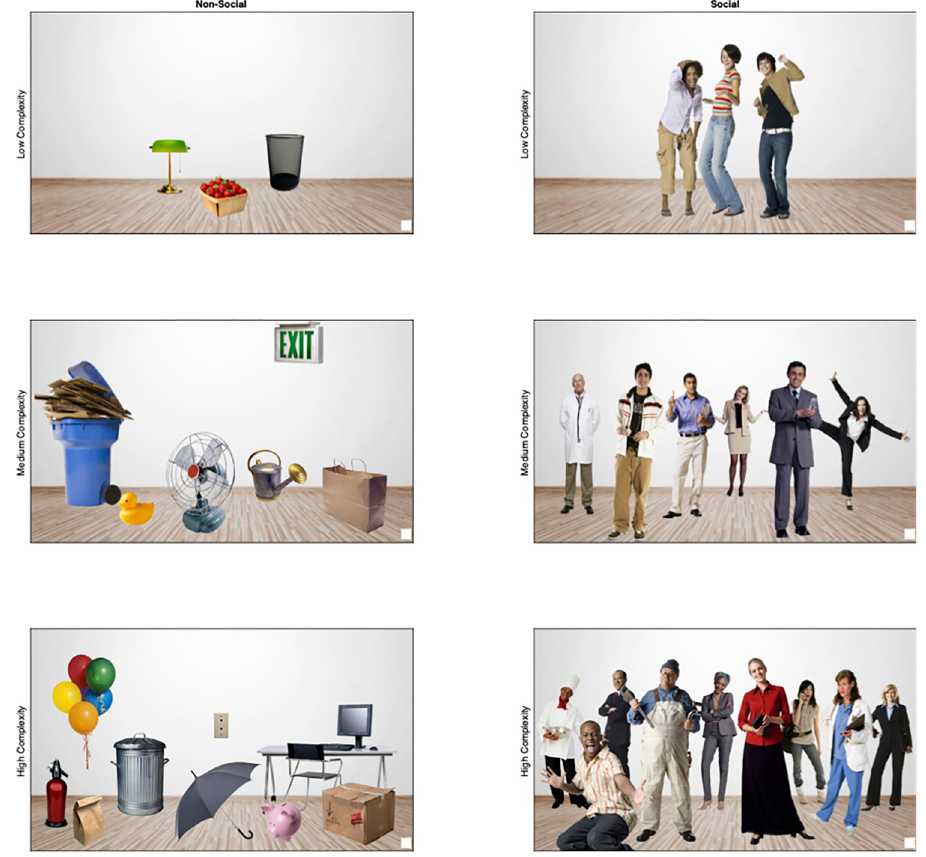
Fig 1. Quasi-naturalistic stimuli used in Experiment 1. Scenes varied by content: non-social (left column) or social (right column) and complexity: low (top row), medium (middle row) and high (bottom row).